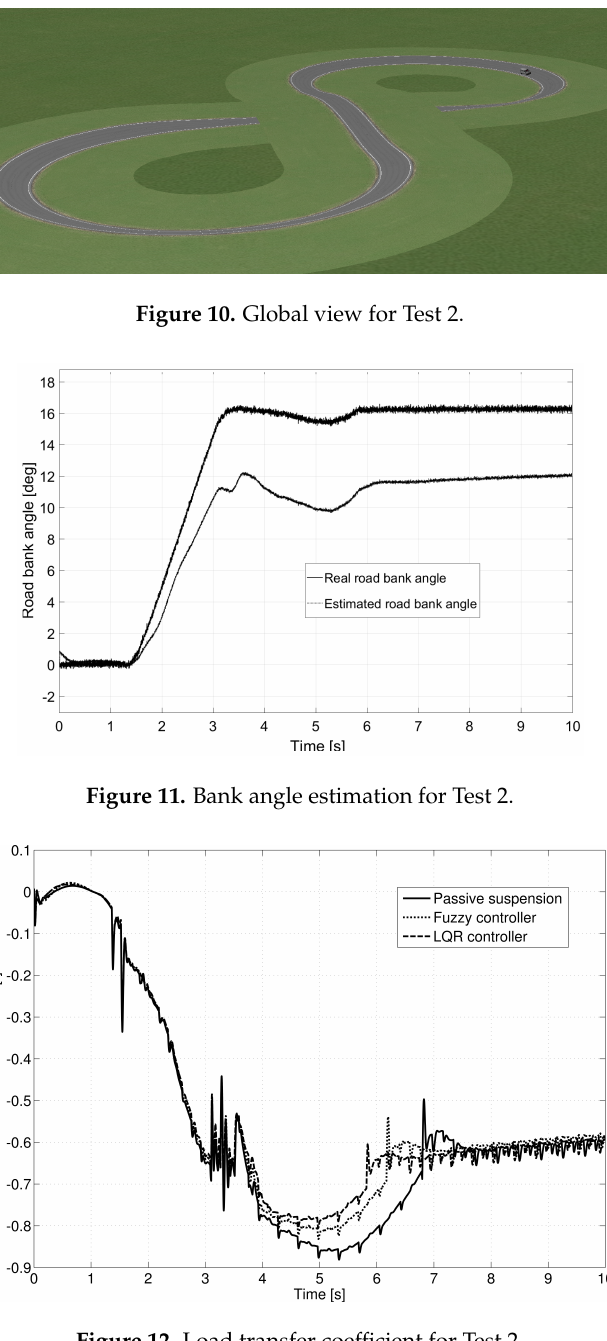
Figure 12. Load transfer coefficient for Test